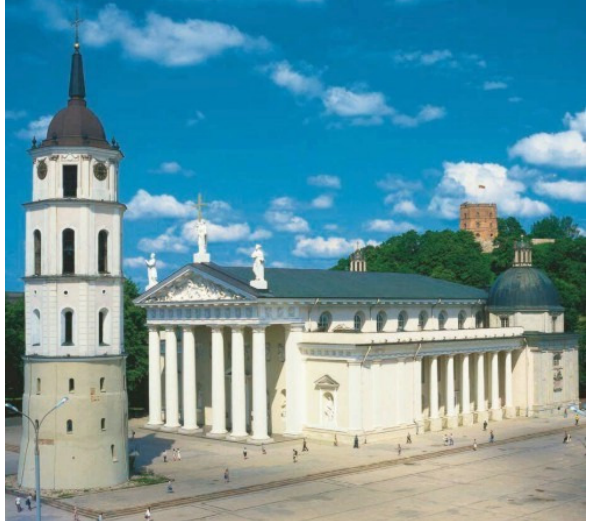
Fig. 1. The Vilnius Archcathedral with the Belfry